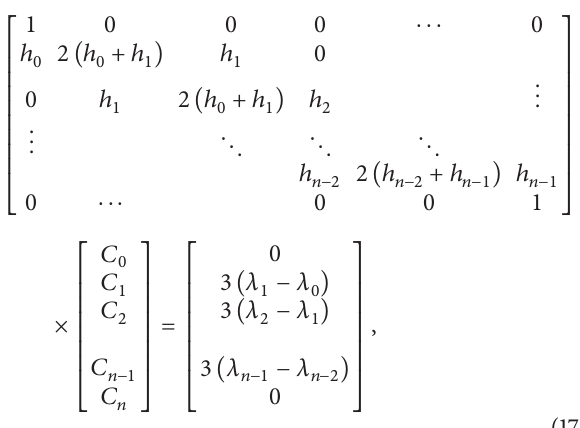
with spline natural condition, which is defined by (17)